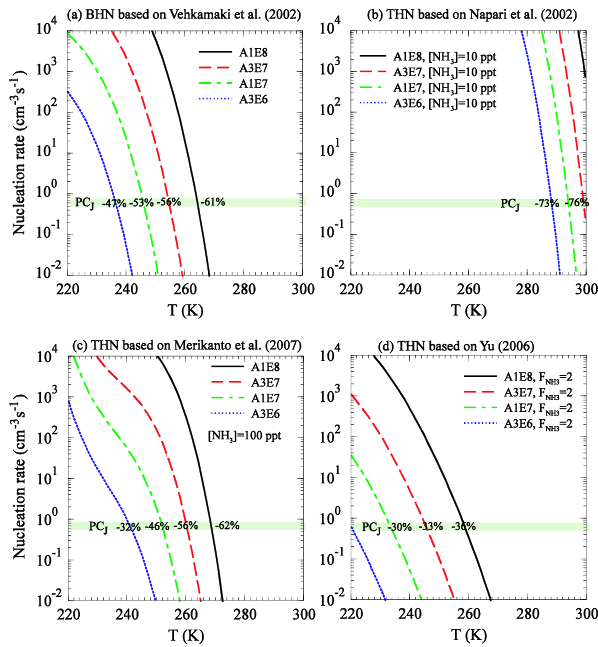
Fig. 2. Effect of temperature ( T ) on H 2 SO 4 -H 2 O binary homo- geneous nucleation (BHN) and H 2 SO 4 -H 2 O-NH 3 ternary homoge- neous nucleation (THN) under a range of atmospheric conditions based on different nucleation models: (a) classical BHN model of Vehkamaki et al. (2002); (b) classical THN model of Napari et al. (2002) with [NH 3 ] = 10 ppt; (c) revised classical THN model of Merikanto et al. (2007) with [NH 3 ] = 100 ppt; (d) Kinetic THN model of Yu (2006) with ammonia stabilizing factor ( F NH strained by experimental results. In the legend, read A1E8 as [H 2 SO 4 ]=1.0 × 10 8 cm − 3 . The percentage change (PC) in the nu- cleation rate ( J ) per degree increase in T at J = 0 . 5cm − 3 s − 1 is also given for each